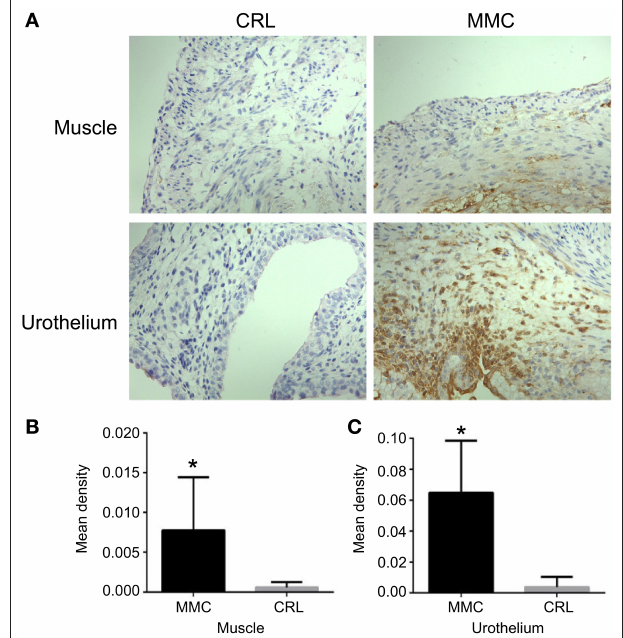
FIGURE 2 | Cell proliferation, apoptosis, and neuromuscular development-related protein changes in fetal rat bladder at E16–E22. (A) Expression of PCNA, cleaved caspase-3, NeuN, and a-SMA proteins in the MMC and CRL groups at E16, E18, E20, and E22. (B–E) The expression of PCNA (B) , cleaved caspase-3 (C) , NeuN (D) , and α -SMA (E) in the MMC and CRL groups changed with the development of the embryos, n = 5, * P < 0.05. Data are expressed as means ± STDs. MMC, myelomeningocele; STD, standard deviation; PCNA, proliferating cell nuclear antigen; α -SMA, α -smooth muscle actin; NeuN, neuron-specific nuclear-binding protein; CRL, control group; CL-caspase3, cleaved caspase-3; GAPDH, glyceraldehyde-3-phosphate dehydrogenase.